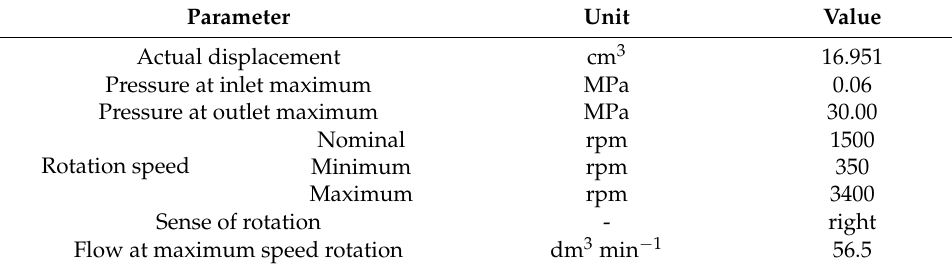
Table 2. Hydraulic gear pump GHD0-17R-S2D2-SG05G04-N.